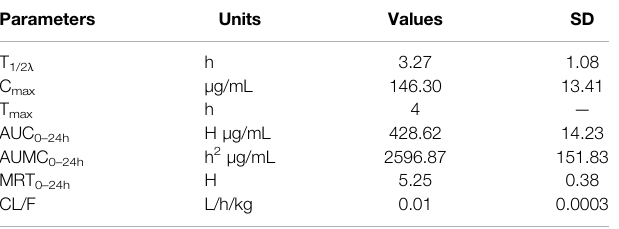
TABLE 3 | Integrated PK parameters for avilamycin in ileal content after oral administration at a dose of 4 mg/kg b.w. ( n = 6).